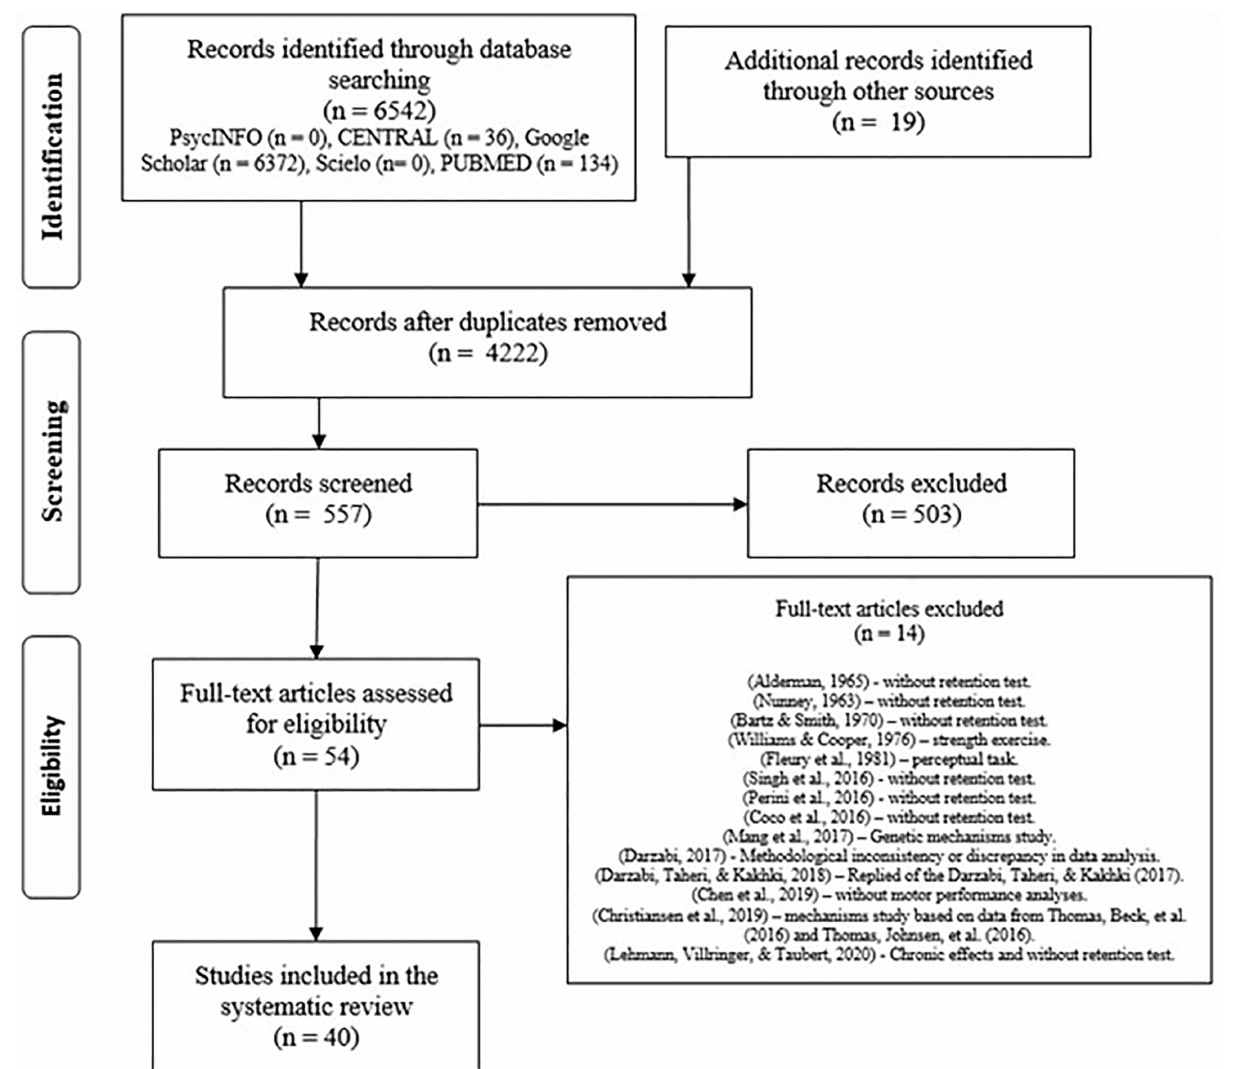
Figure 1 - Flowchart of the